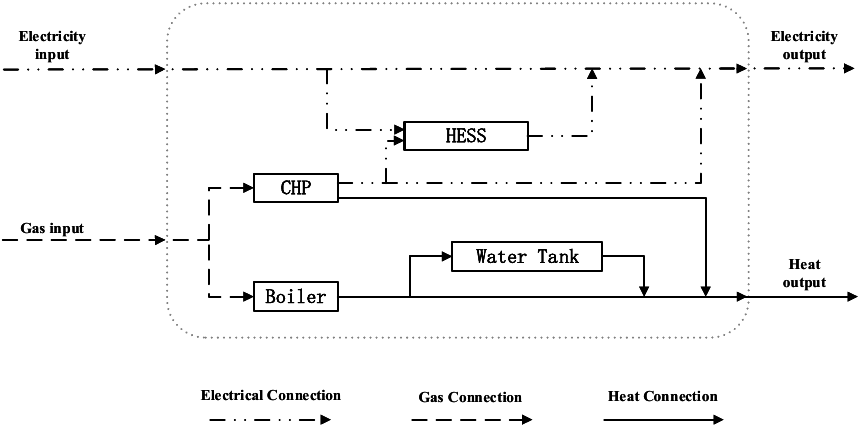
Figure 3. Energy flow in smart building.